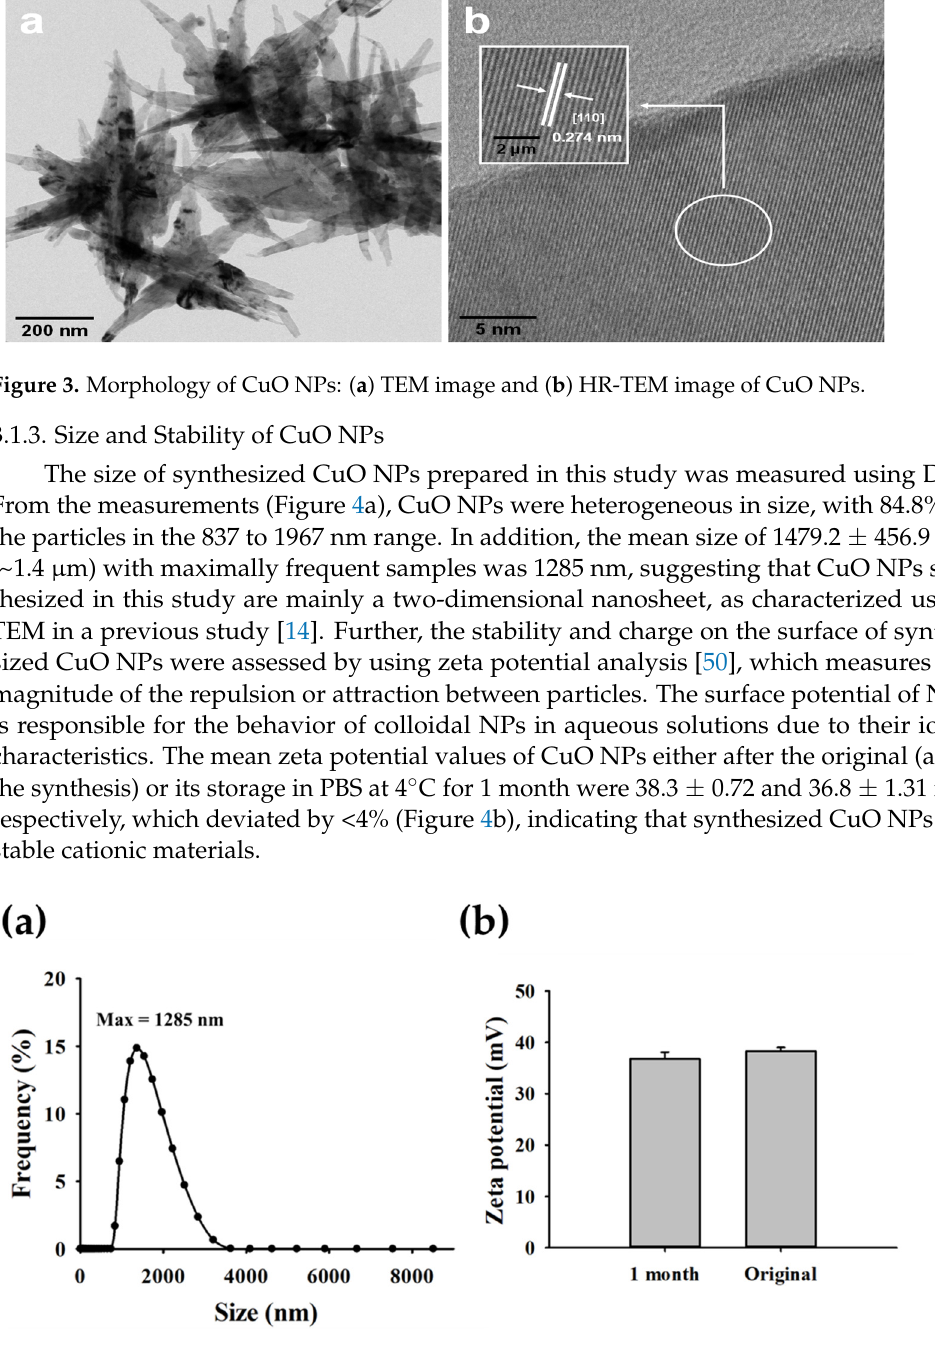
Figure 2. XRD pa tt ern of CuO NPs.